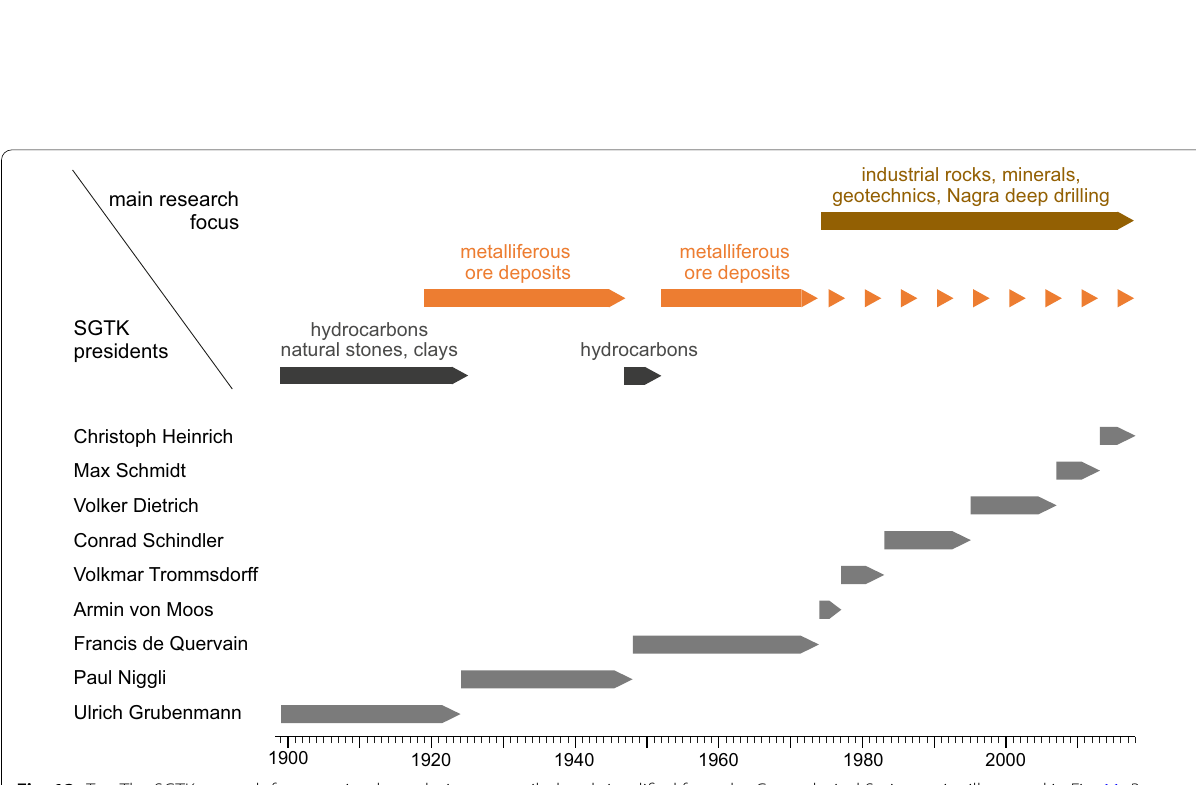
Fig. 12 Top : The SGTK research focus topics through time, compiled and simplified from the Geotechnical Series topics illustrated in Fig. 11. Bottom : Chronological overview of the SGTK presidents. All presidents were professors at Earth Sciences institutes at ETH Zurich except A. Von Moos. Their presidential terms were: U. Grubenmann 1899–1924, P. Niggli 1924–1948, F. de Quervain, 1949–1974, A. von Moos 1975–1977, V. Trommsdorff 1978–1983, C. Schindler 1984–1995, V. Dietrich 1996–2007, M. Schmidt 2008–2013, C. Heinrich 2014–2018. Note the apparent coincidence of